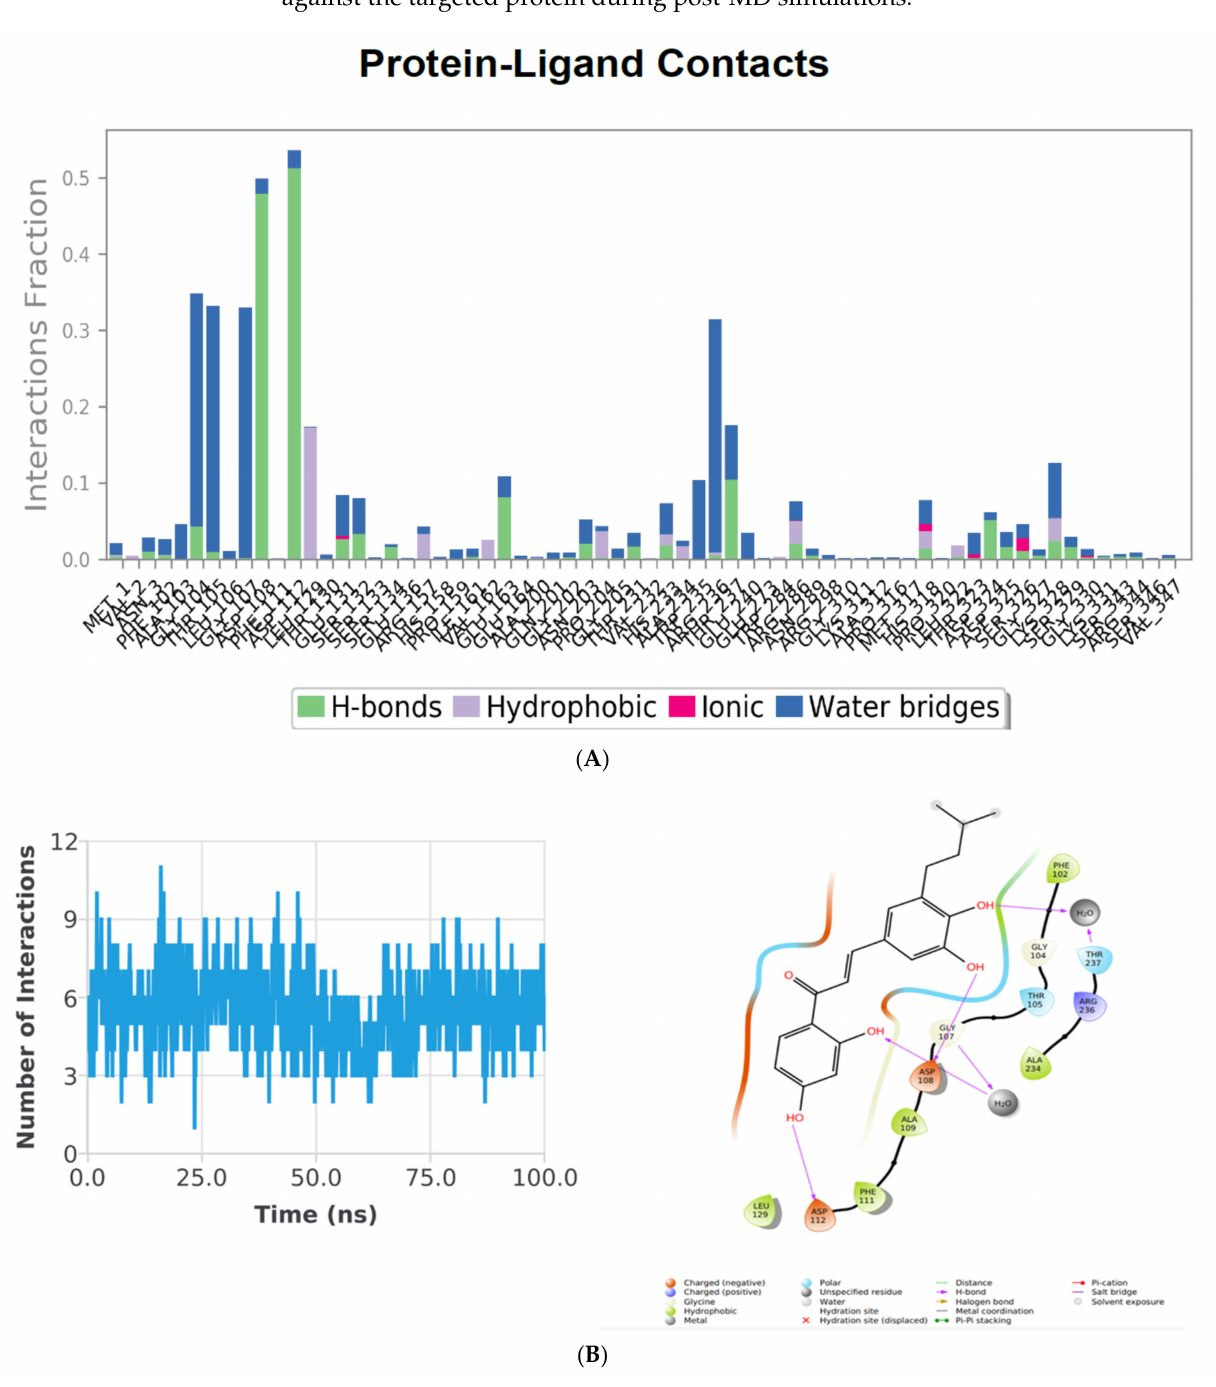
Figure 9. ( A ) Protein ligand contacts plot for heterodimeric PhcA–ZINC000014762512 receptor com- plex throughout the simulation. ( B ) Blue lines display H-bonds deviation observed in interaction during 100 ns simulation in Holo state. Post-MD simulations of intermolecular H-bonding, electro- static, and hydrophobic contacts formed between PhcA–ZINC000014762512 complex. The image was drawn by Plot and the ligand interaction module of